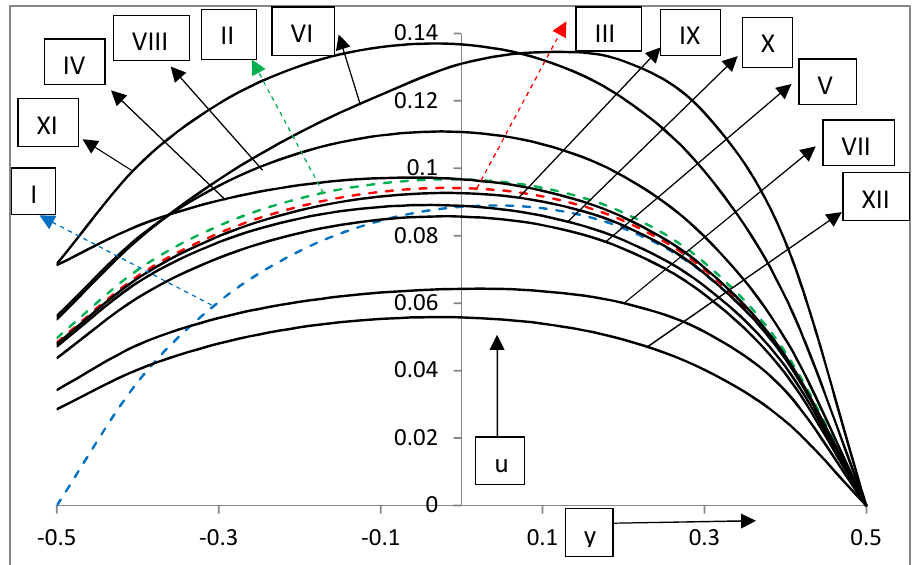
Figure 2. Velocity profiles for z=0.5 and t= π /2.